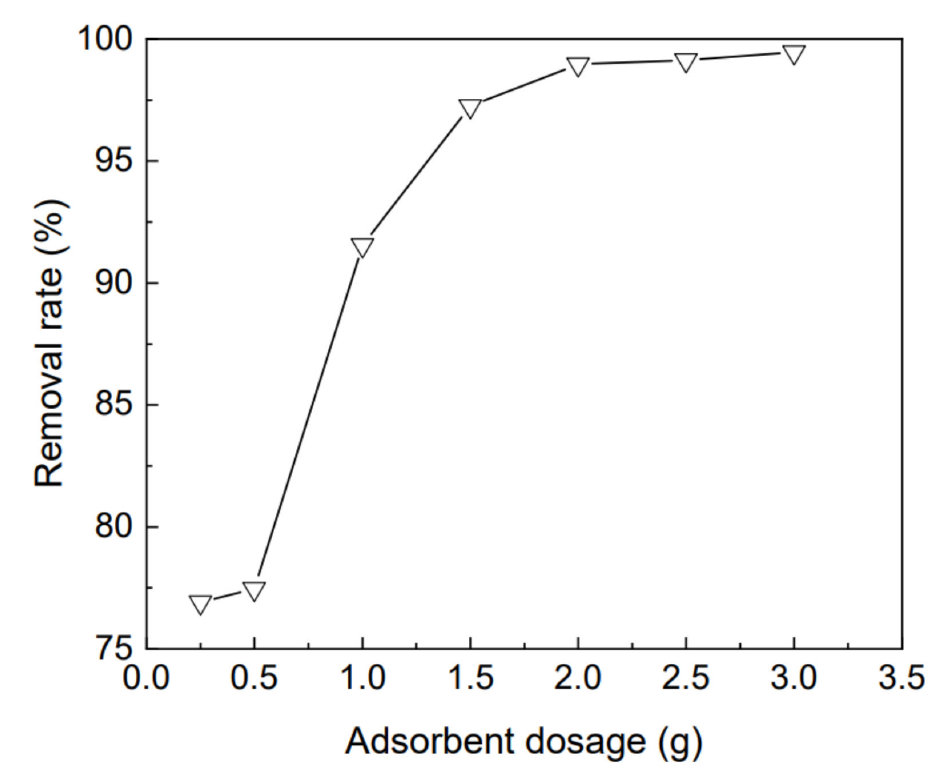
Figure 7. Variation of the removal rate of kaolin-organic bentonite for 50 mg/L rhodamine B with adsorbent